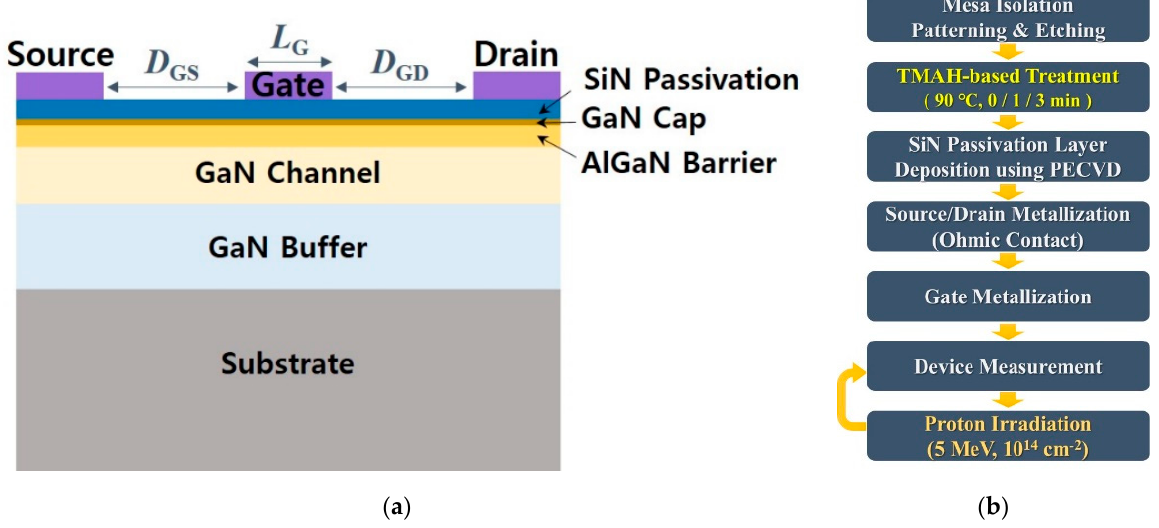
Figure 1. ( a ) Schematic cross-section of the SiN-passivated AlGaN/GaN metal-insulator-semiconductor high-electron mobility transistor (MIS ‐ HEMT). ( b ) Process flow for the fabrication and proton irradiation.